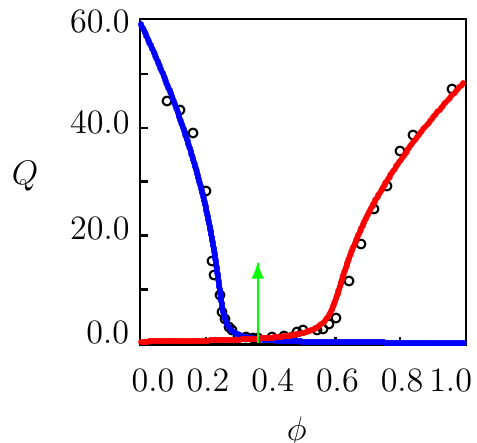
Figure 1. Equilibrium degree of swelling Q versus volume fraction of cosolvent. Circles: experimental data PNIPAAm gel in water/methanol mixture at temperature T = 20 ◦ C [20]. Solid lines: results of numerical analysis. Arrow indicates the volume phase transition